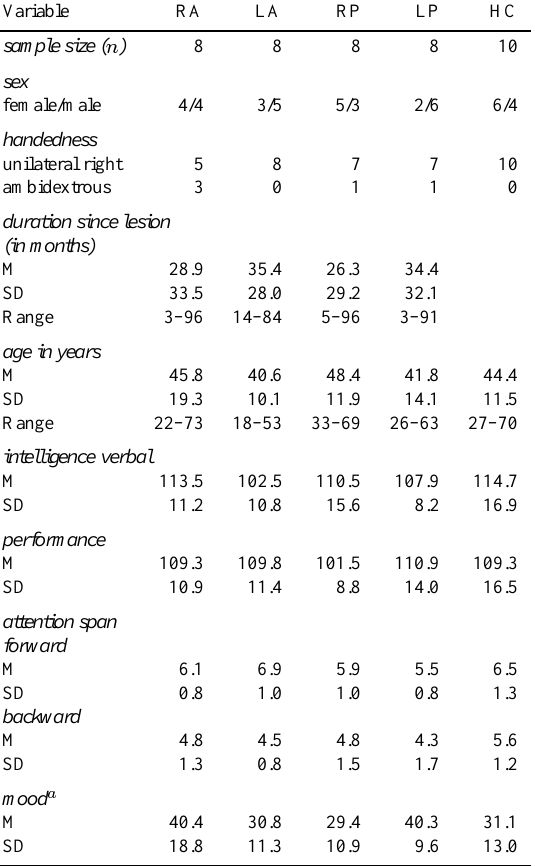
Table 3 Demographic and neuropsychological data (patients with Parkin- son’s disease and healthy